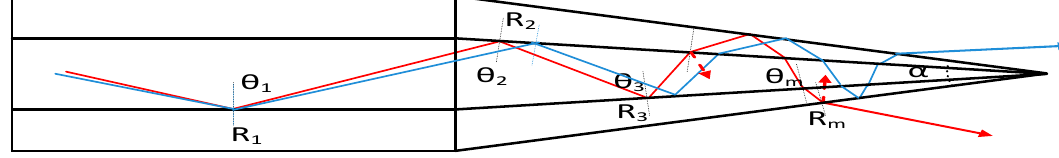
Figure 8. Ray optics in smooth MM fiber taper.